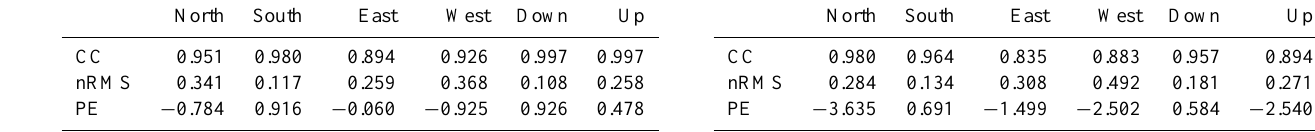
Table 1. Three metrics computed on the basis of the values in Fig. 8. North